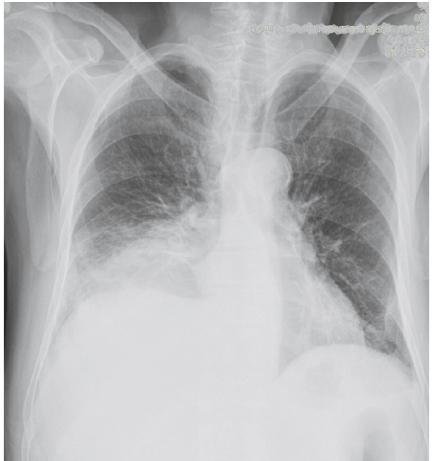
Figure 3: Pneumonic infiltration on chest